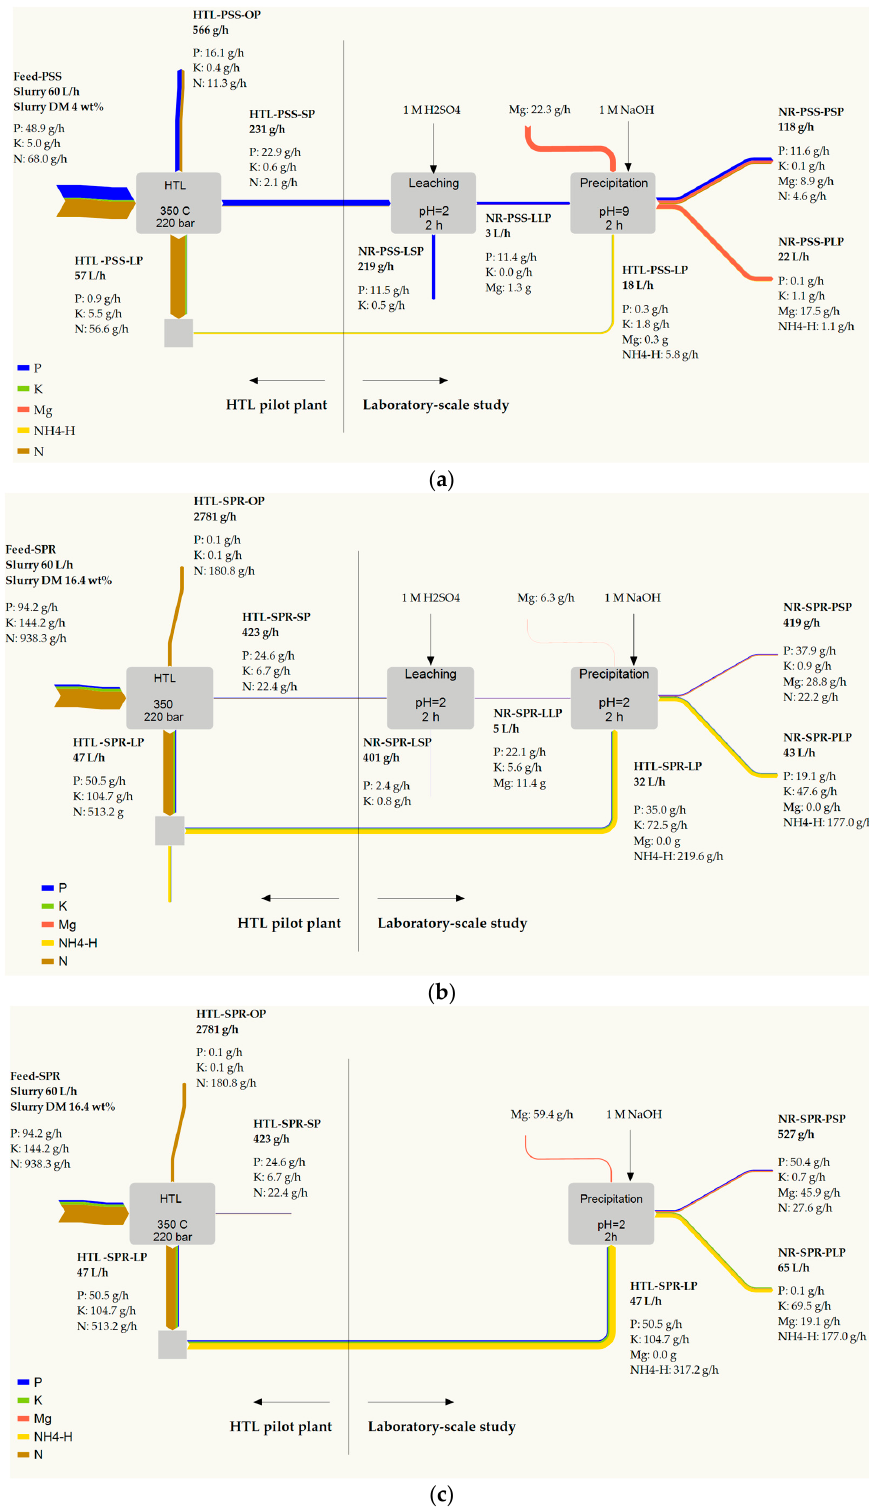
Figure 6. Overall process considerations and mass flow of macronutrients for HTL of PSS ( a ) and SPR ( b , c ). The sample ID can be found in Figure